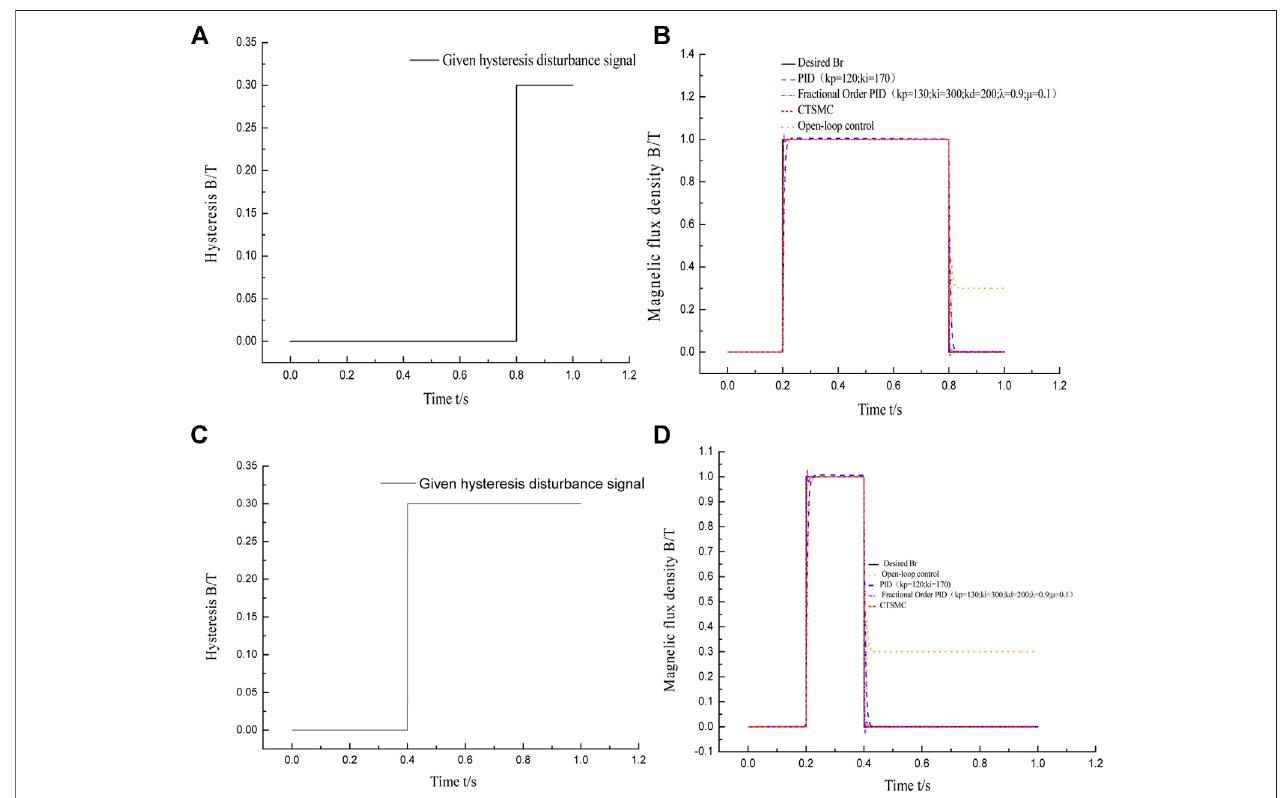
FIGURE13| Fourcontrolresponses ofdifferent low-frequency inputsignals. (A) Hysteresiscurve. (B) Response offour controlmultistepfunctions. (C) Hysteresis curve. (D) Response of four control window functions.